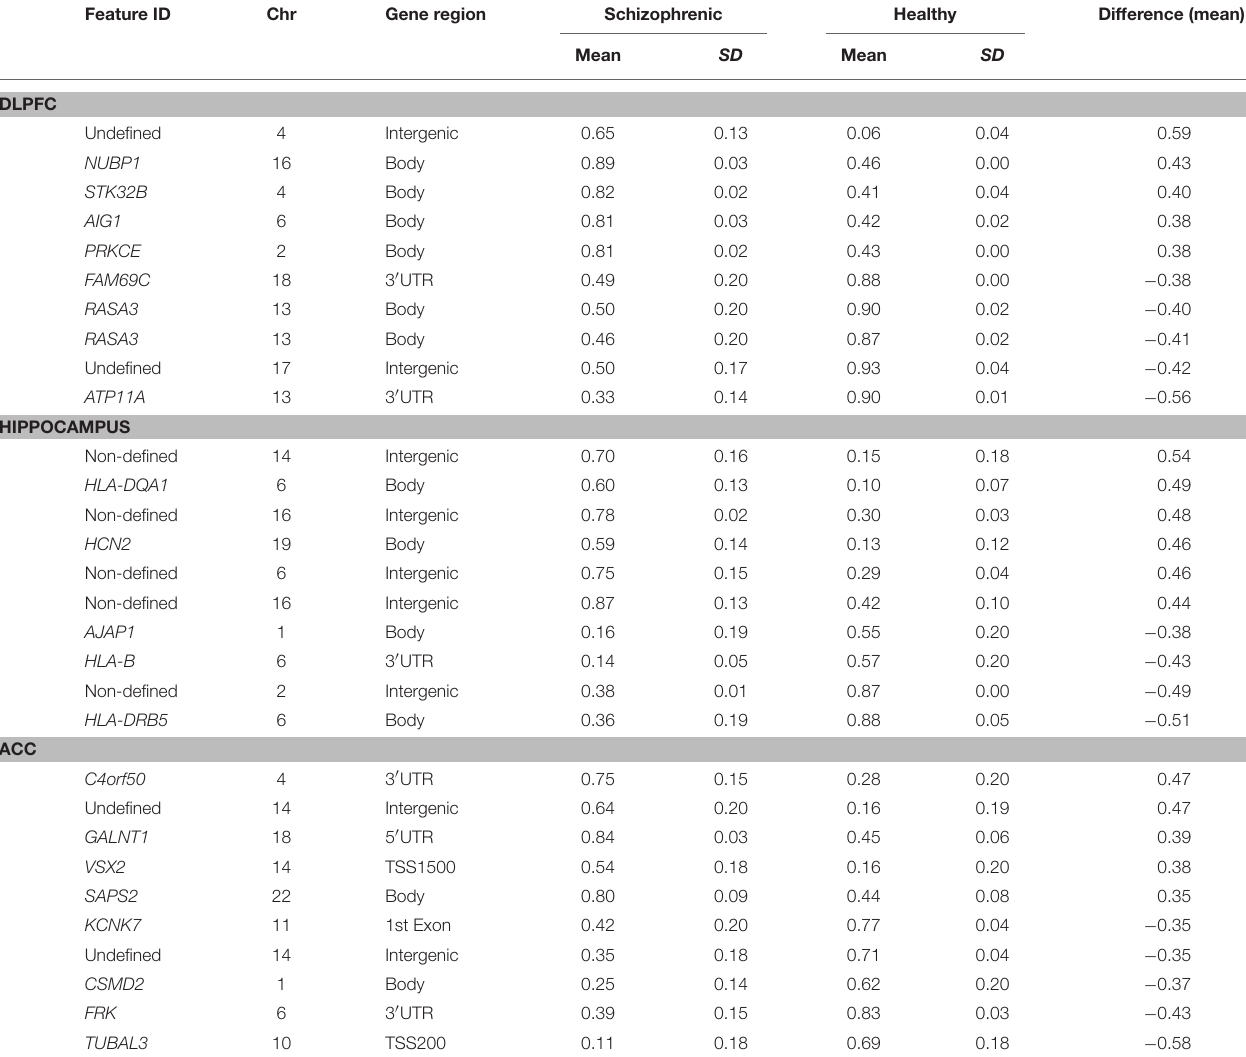
TABLE 1 | The 10 most differentially methylated probes after Bonferroni’s correction ( p < 10–7; β > 0.2) in the different areas analyzed between schizophrenic and healthy